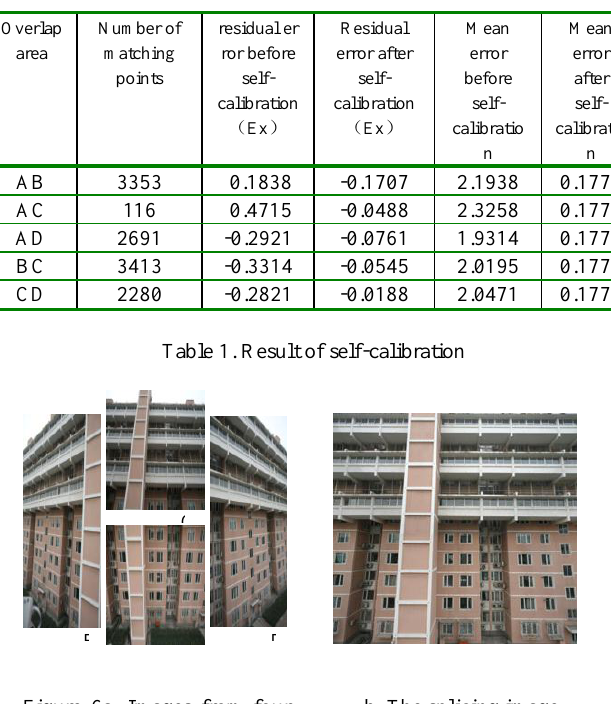
Figure 6a. Images from four- calibrated